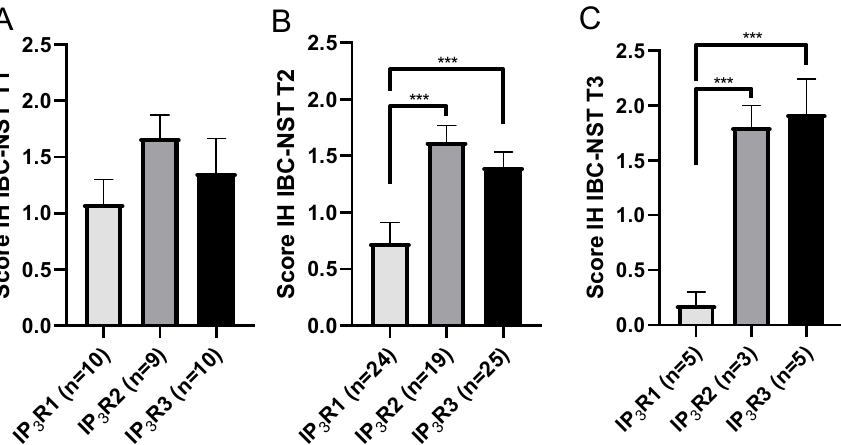
Figure 2. The IP 3 R IH expression score, as a function of tumor size ( A – C ). The IP 3 R IH expression scores did not differ significantly in T1 BC ( A ). The IP 3 R2 and IP 3 R3 IH expression scores were sig- nificantly higher than IP 3 R1 score in T2 and T3 BCs ( B , C ). *** p < 0.001.